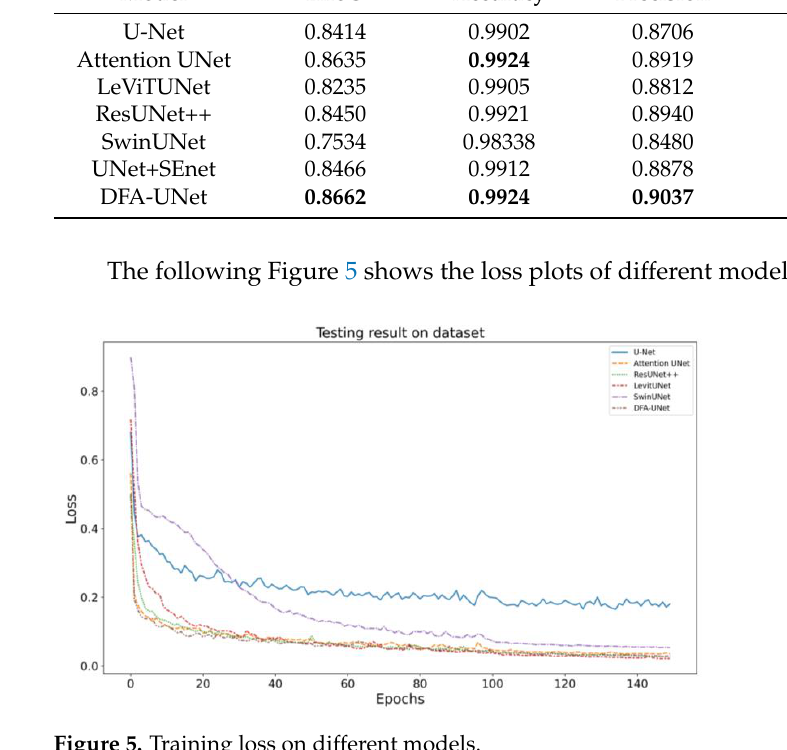
Table 1. The results of the evaluation on the dataset.